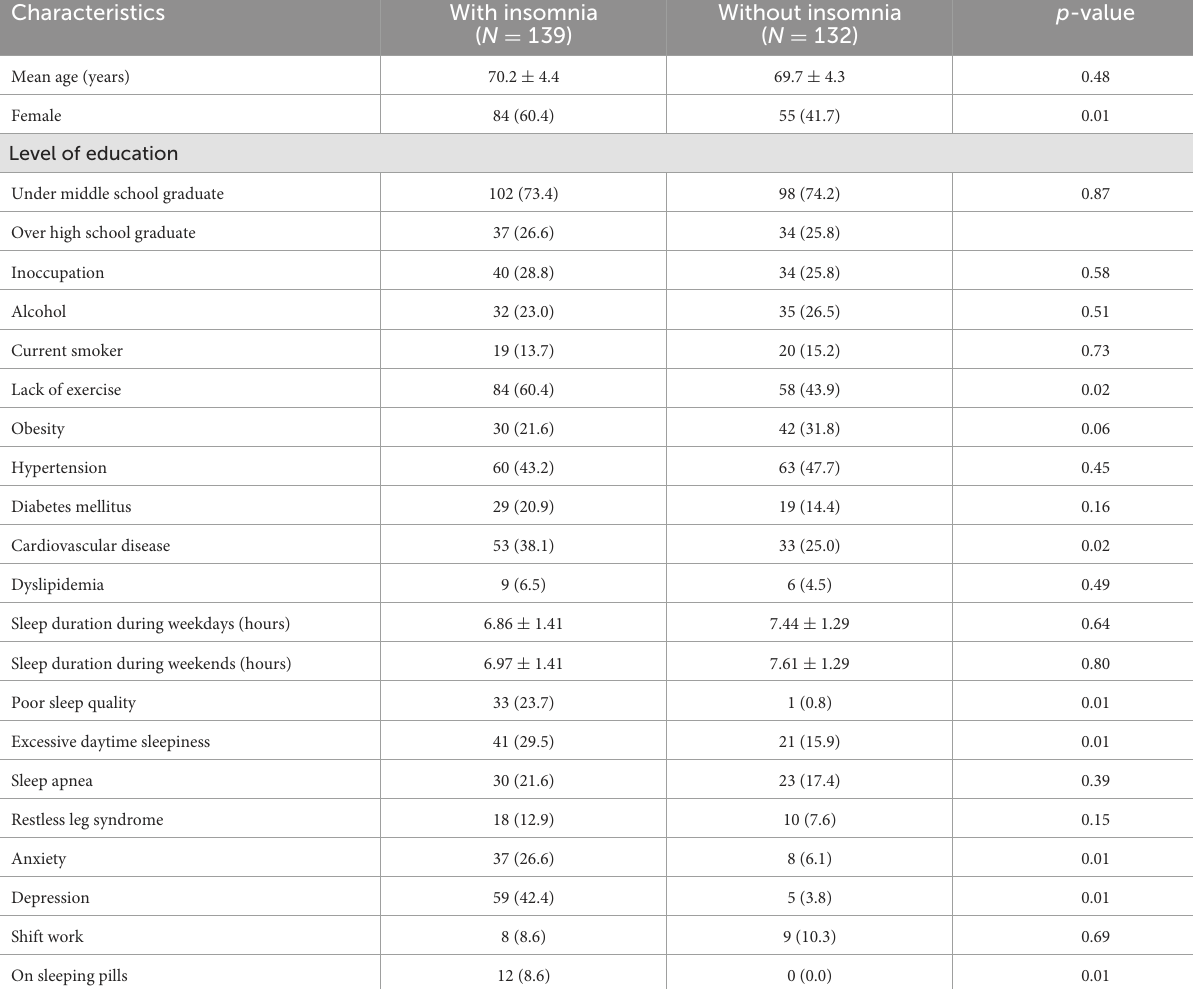
TABLE 4 Comparison between elderly individuals with and without insomnia.